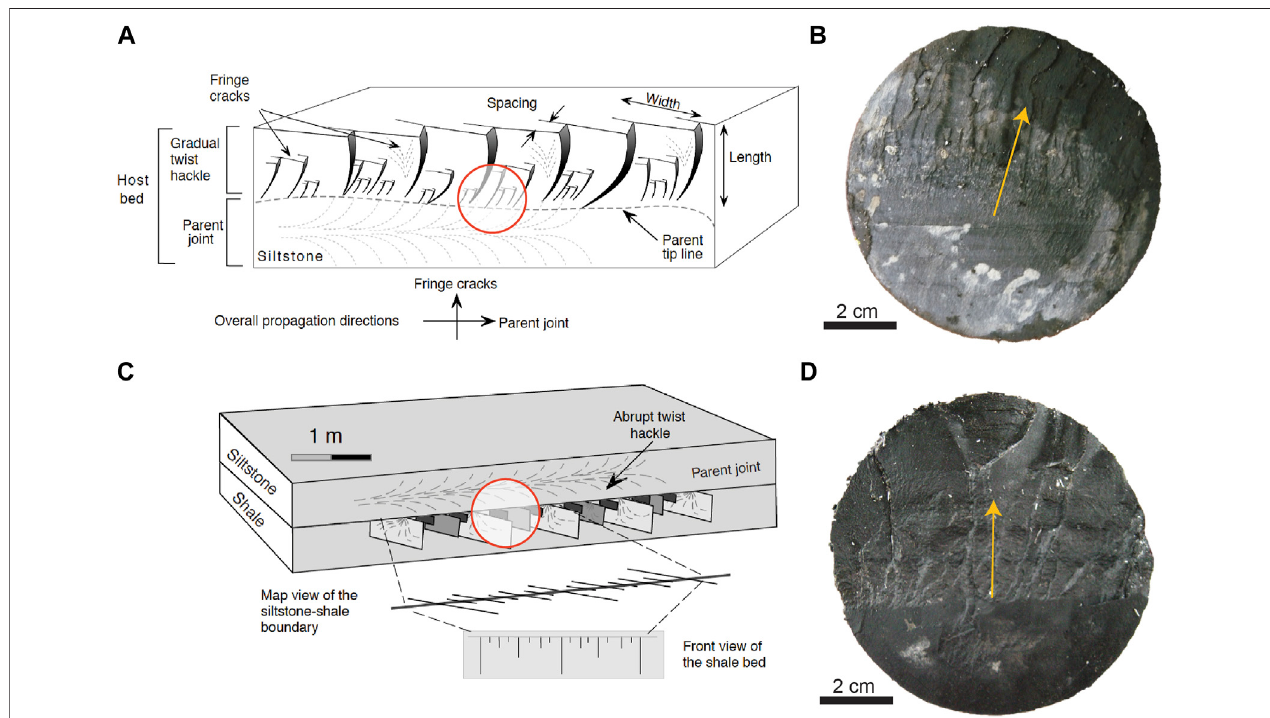
FIGURE4|(A) FigurefromYounes&Engelder(1999)showinggradualtwisthacklesformingfromplumosewithinabedandgrowingorthogonally,curvingoutand up and increasing in crack displacement to the bed boundary. The hypothetical location of (B) is shown with the red circle. (B) An example of a gradual twist hackle in core, with growth upward in the direction if the yellow arrow. (C) Figure from Younes & Engelder (1999) showing parent fracture with plumose structure in the overlying siltstone bed,withabrupt twisthacklesforming orthogonally fromthelowerbed boundaryand propagatingintotheunderlying shale unit.Thehypotheticallocation of part D isshown withthe red circle where lithology changesand fracture breakdown istriggered. (D) An exampleofabrupt twist hackles incore, with indicated growth upward from the dark shale unit into the rough carbonate rich shale unit.